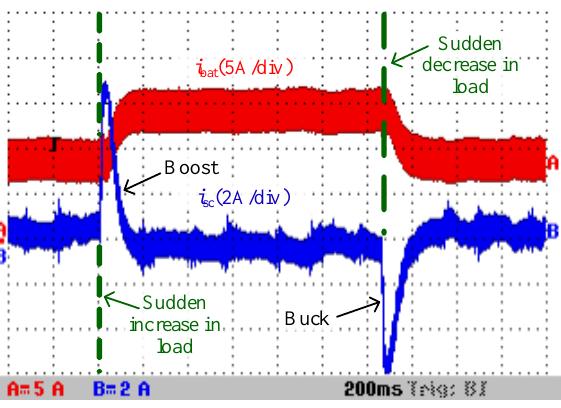
Figure 21. The output current waveforms of the battery and the super-capacitor (SC).